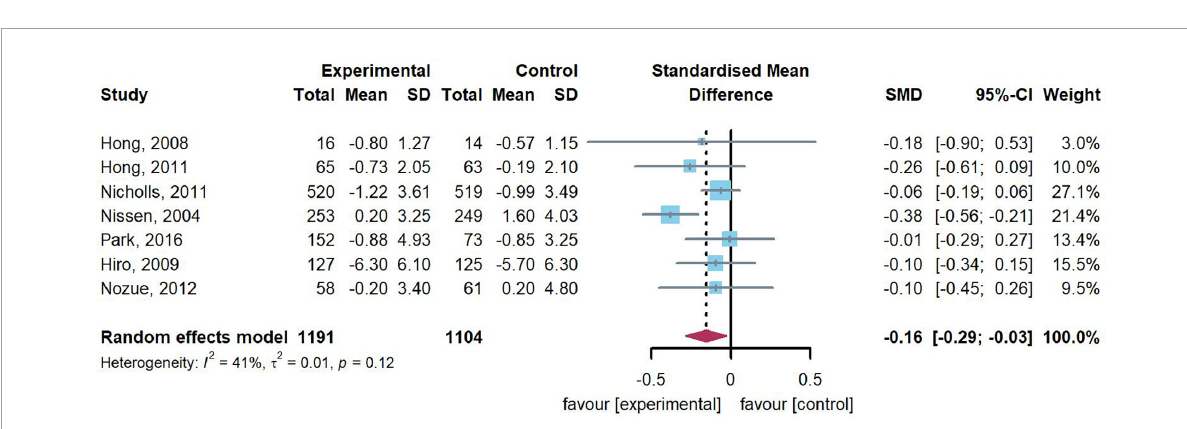
FIGURE3 Forest plot of change of PAV. A meta-analysis of 7 studies reported a significant reduction in change of PAV [standardized mean difference (SMD): –0.16, 95% confidence intervals (CI): –0.29, –0.03], compared with the control.